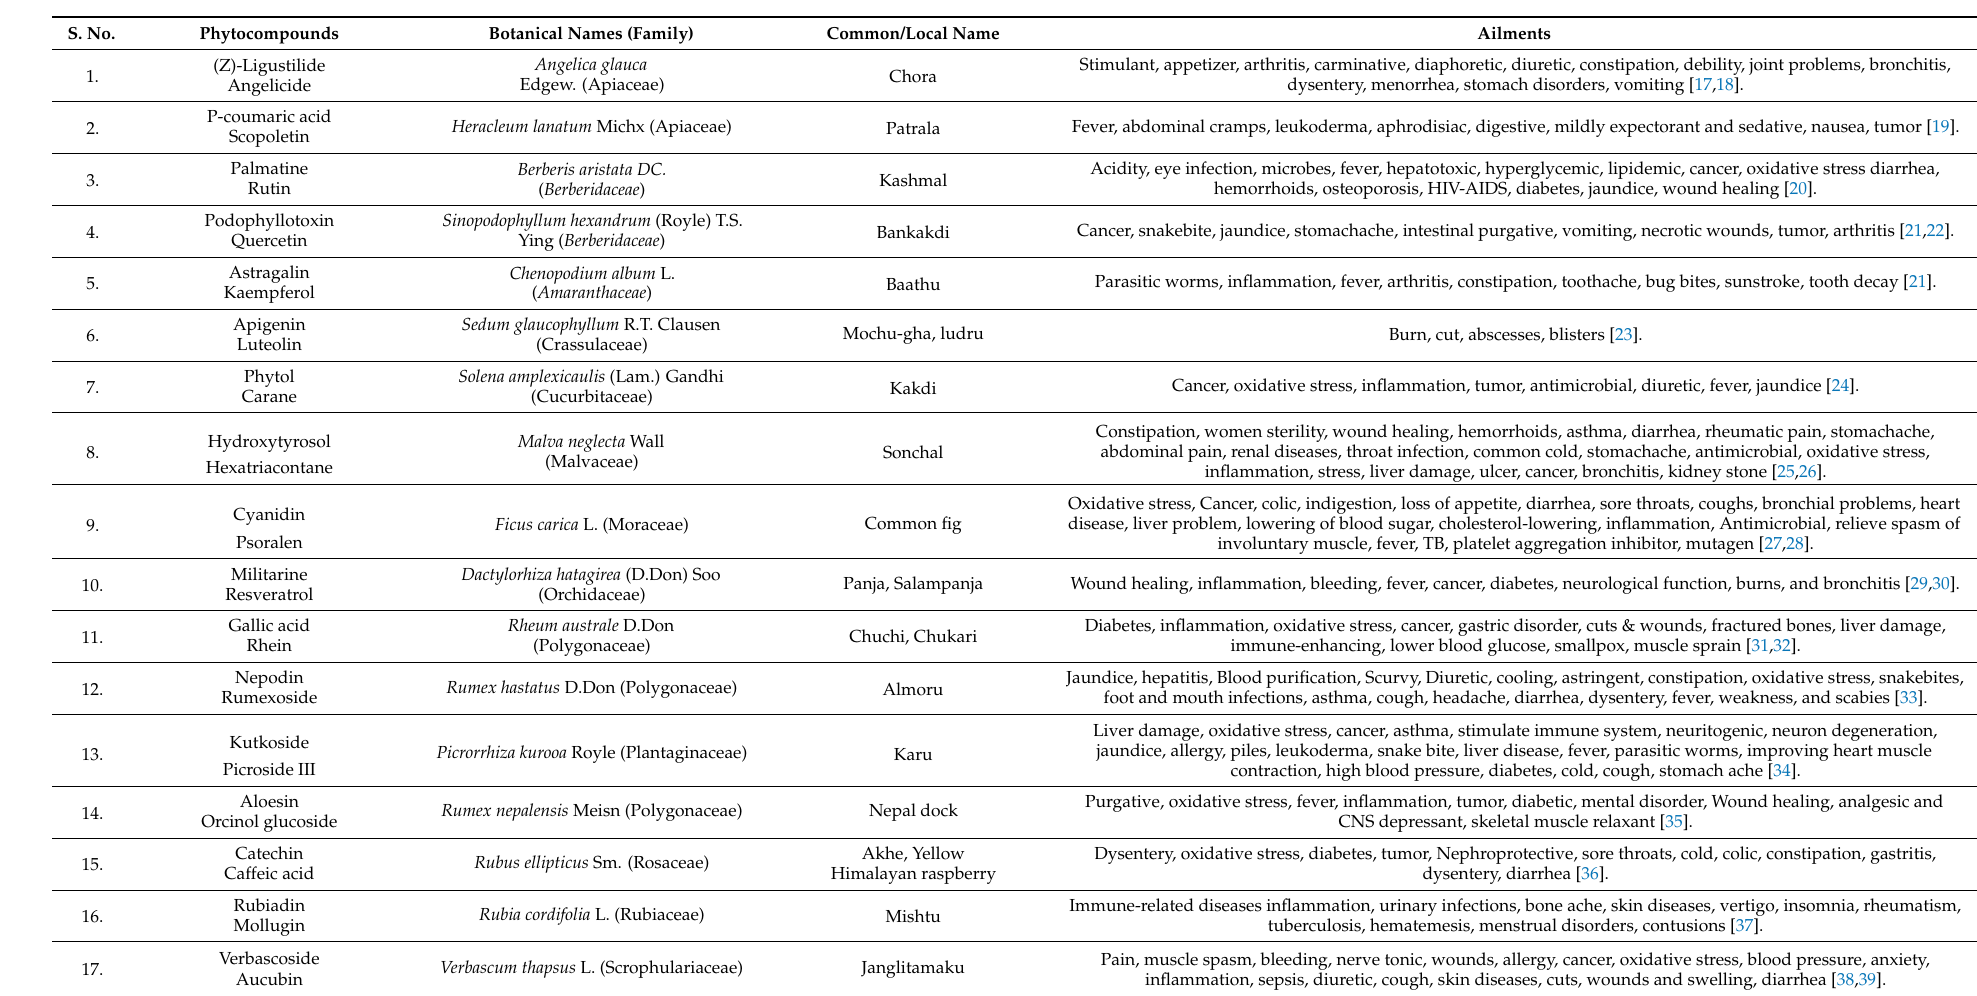
Table 1. Medicinal plants used for molecular docking with their uses in various